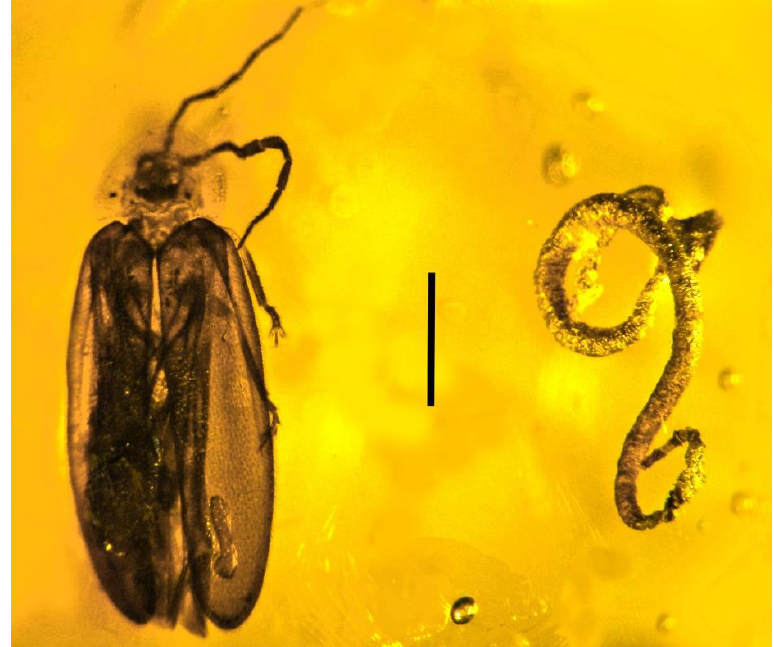
Figure 34. A mermithid nematode, Heydenius lamprophilus (Nematoda: Mermithidae) that emerged from its lampyrid (Coleoptera: Lampyridae) beetle host in Dominican amber. Scale bar = 1.9 mm.